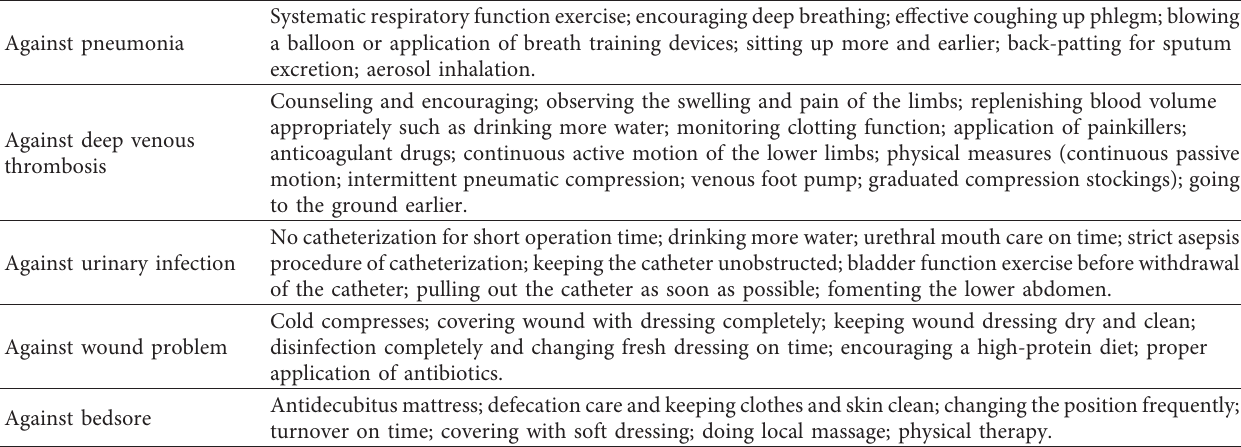
Table 3: Partial specific measures against complications of wholly compensatory nursing, partially compensatory nursing, and supportive educative nursing in the experiment